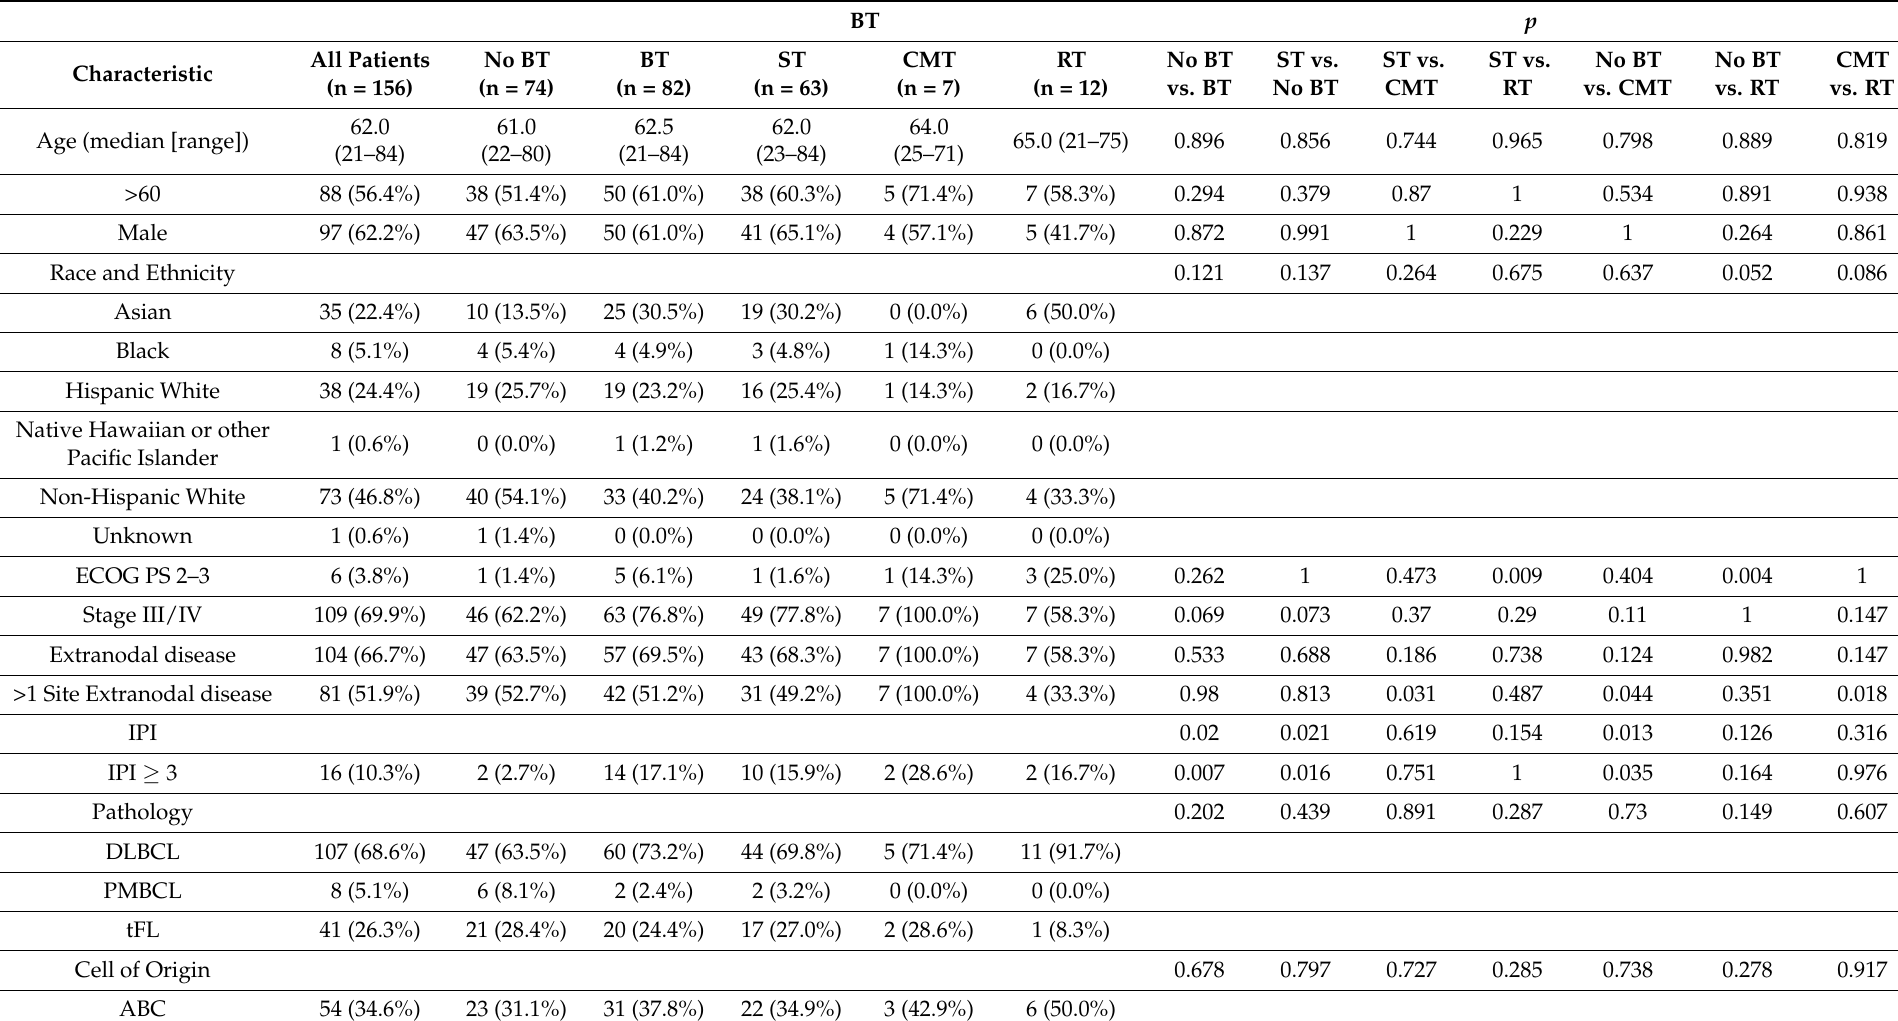
Table 1. Patient and treatment characteristics of patients who underwent CAR T-cell therapy according to type of bridging therapy. BT